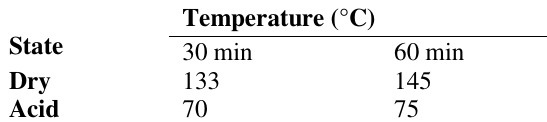
Temperatures of